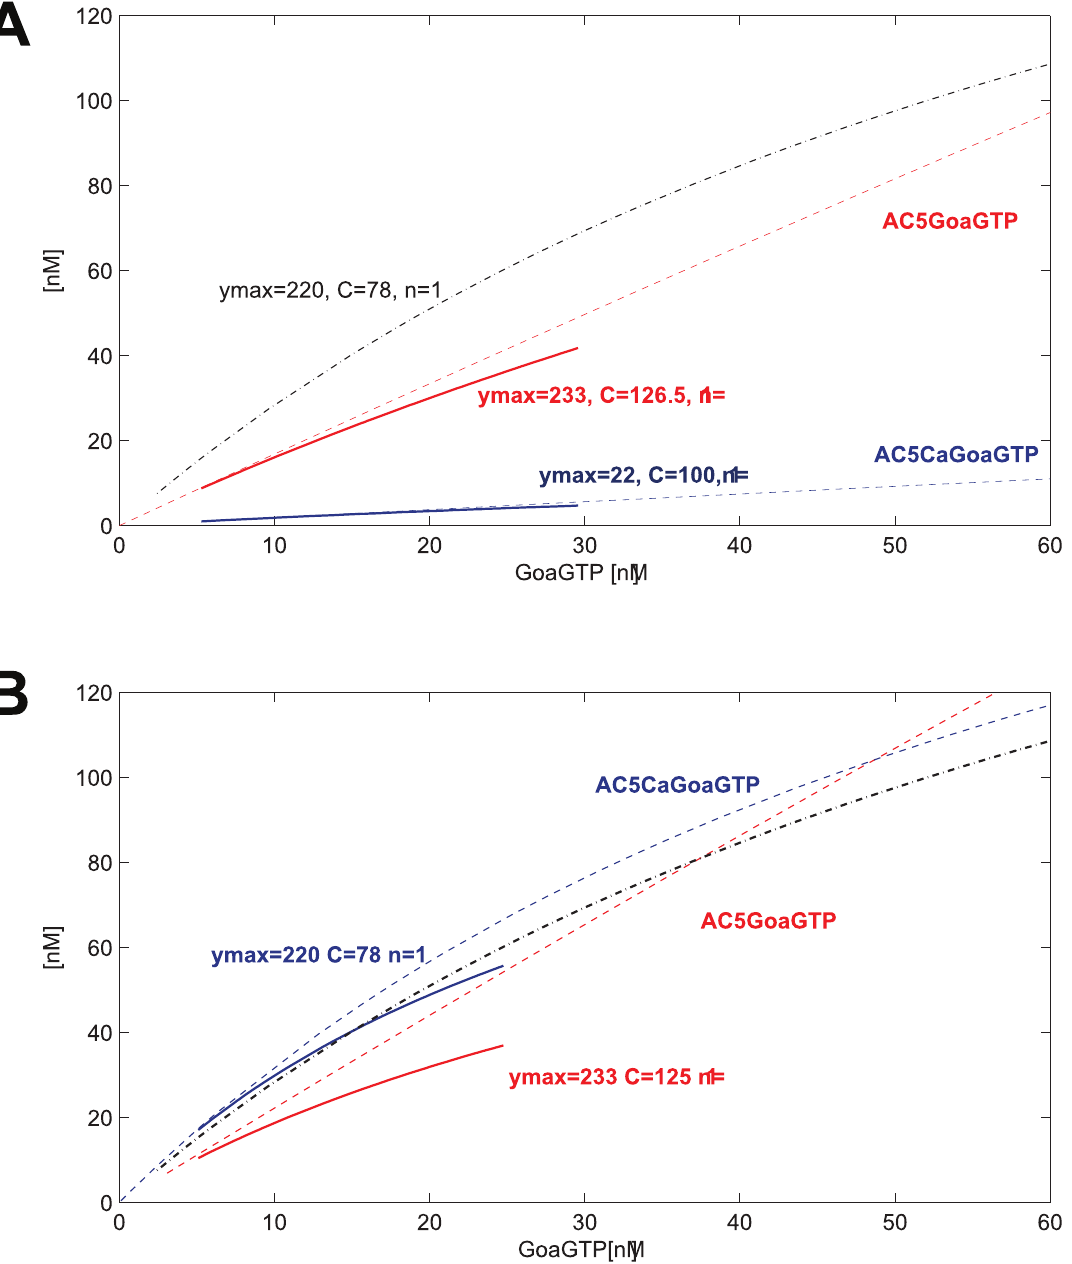
Figure 4. Local adjustment of a transfer function. A. Elementary (dashed) and systemic (continuous) psfs for two targets of GoaGTP. A new systemic psf for GoaGTP-AC5CaGoaGTP is defined by functional parameter adjustment (black line). B. Elementary parameters were changed to match the new systemic psf. For AC5CaGoaGTP, k on =0.0192, k off =25 was adjusted to k on =0.022, k off =1.5, for AC5GoaGTP, k on =0.0385, k off =50 was adjusted to k on =0.0495, k off